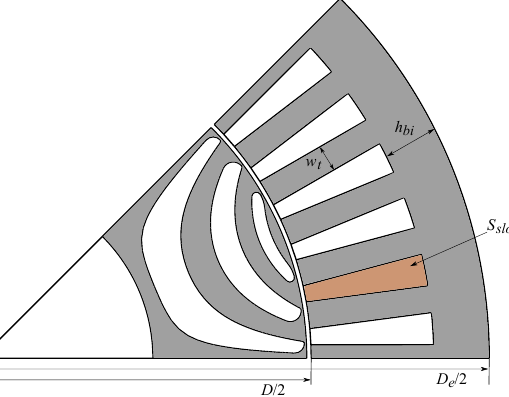
Figure 5. Simplified drawing of the SynRM with “trapezoidal-shape”